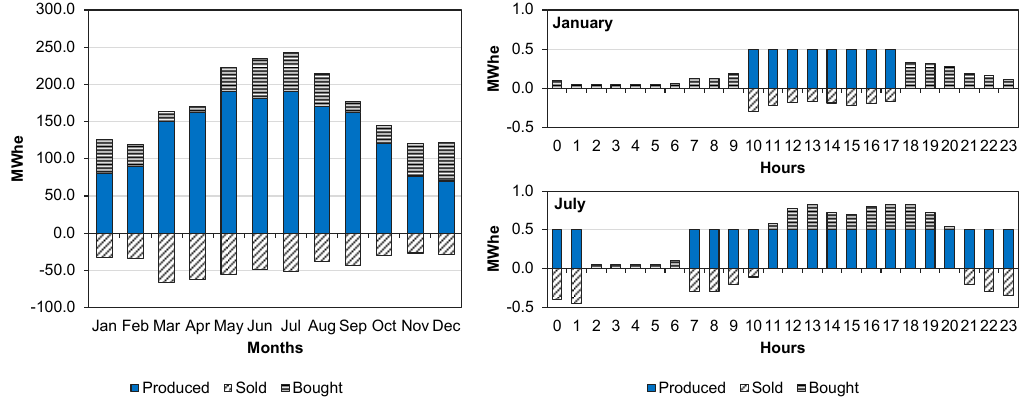
Figure 12. System A. Electricity produced, bought and sold on working days. Monthly values (left side) and hourly values (right side).